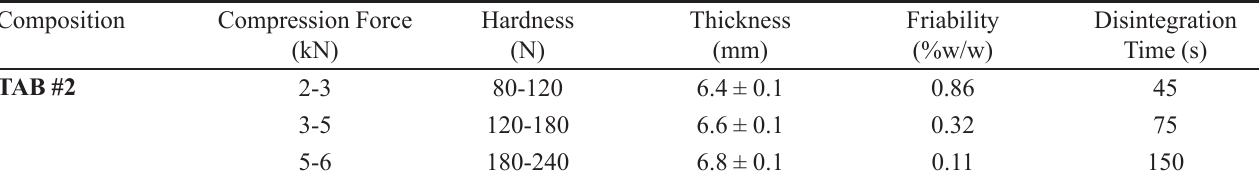
TABLE IV - Physical characterization data of compressed tablets using optimized composition Composition